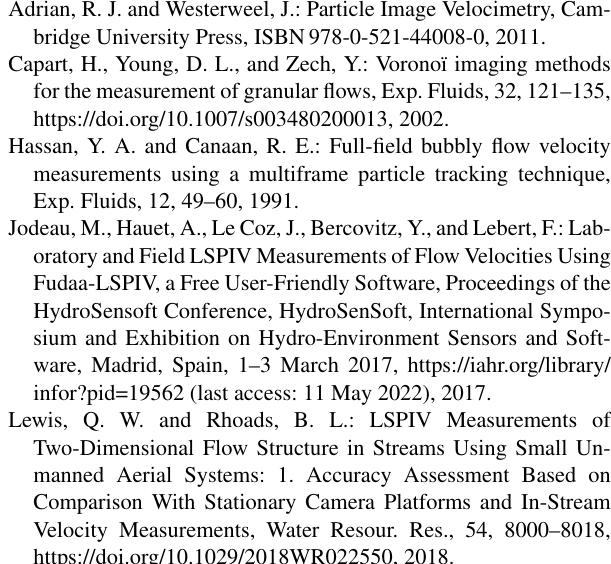
of where the participants and lecturers come from. Here the locations of affiliation and not nationality are considered.